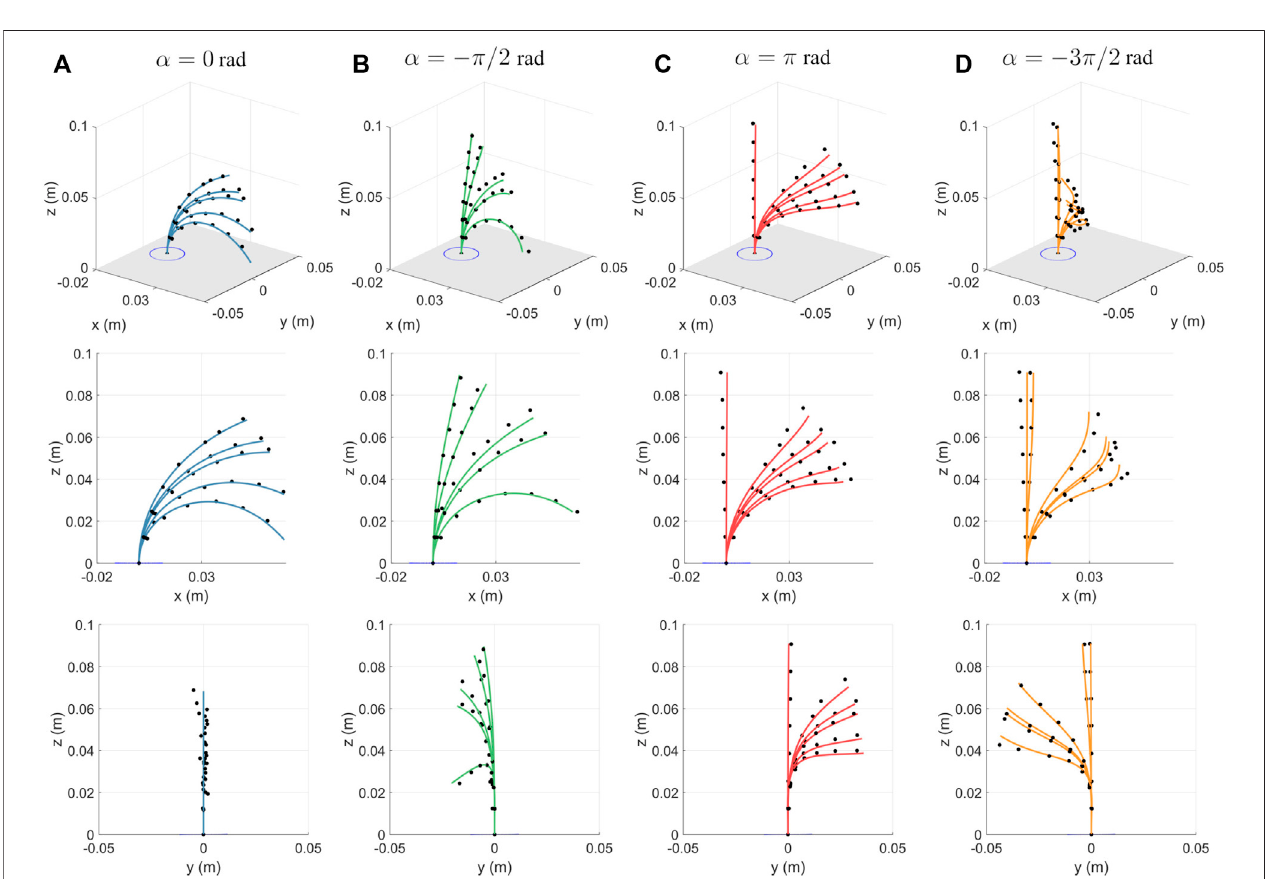
FIGURE6 | For different tension values, experimental measurements (in black dots) plotted against the backbone curve predicted by the proposed model for (A) α = 0, (B) α = − π /2 rad, (C) α = π rad, and (D) α = − 3 π /2 rad. The fi gures show the 3D plot (top row), projection on the xz -plane (middle) and the projection on the yz -plane